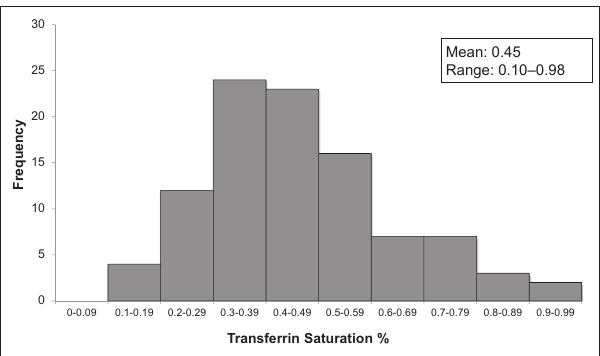
Figure 2) Histogram of transferrin saturation levels at the time of genotyping